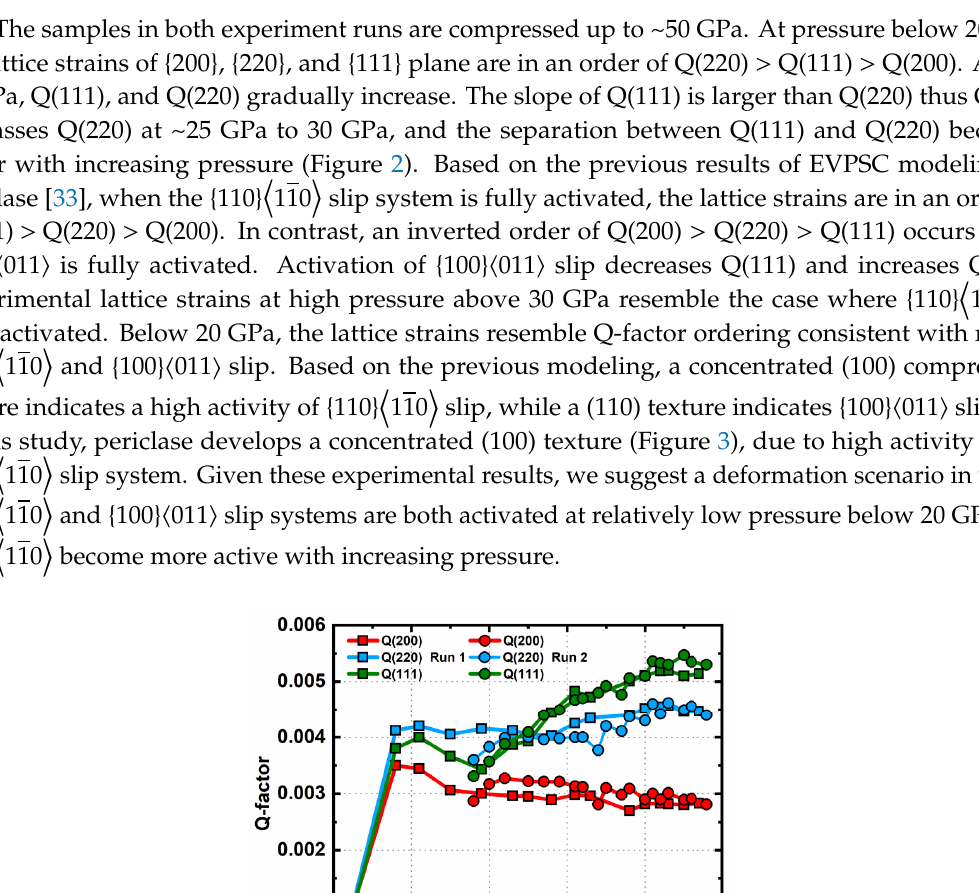
Figure 3. Experimental lattice strains of {200}, {220}, and {111} planes. Rectangles represent data in Run 1; circles represent data in Run 2 . In order to clarify and quantify this suggestion, we model the lattice strain and texture development in Run 1 using EVPSC method. The related modeling parameters are listed in Table 1. A stress exponent of 8 is chosen for dislocation glide in a relatively rate-insensitive material. Theoretical calculations show that {111}〈11̅0〉 slip system is unlikely to activate at room temperature (e.g. [44]). Furthermore, activation of the {111}〈11̅0〉 system will give an intense (110) texture and Q-factors all with similar magnitudes [33]. Consequently, a very high CRSS is given to {111}〈11̅0〉 in order to fully suppress this system. Below 20 GPa, the CRSS of {110}〈11̅0〉 and {100}〈011〉 are set in order to match experimental lattice strains. In the experiments, we do not observe a decrease of all lattice strains. Thus, the increased activity of {110}〈11̅0〉 slip system is